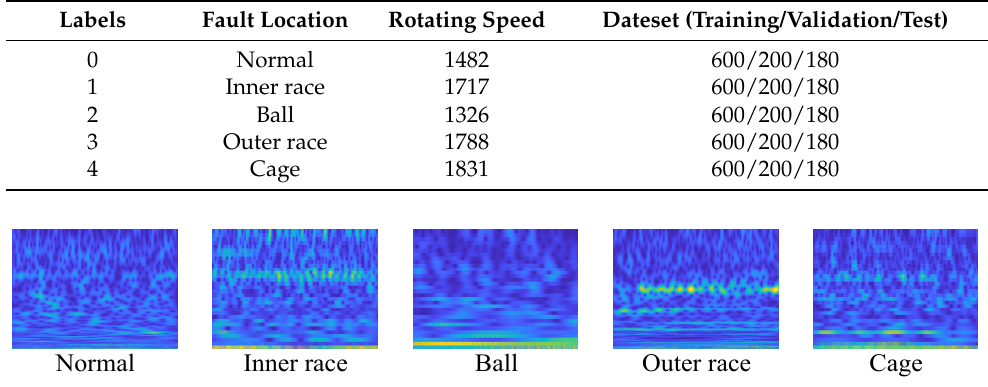
Table 1. Rolling bearing fault dataset.